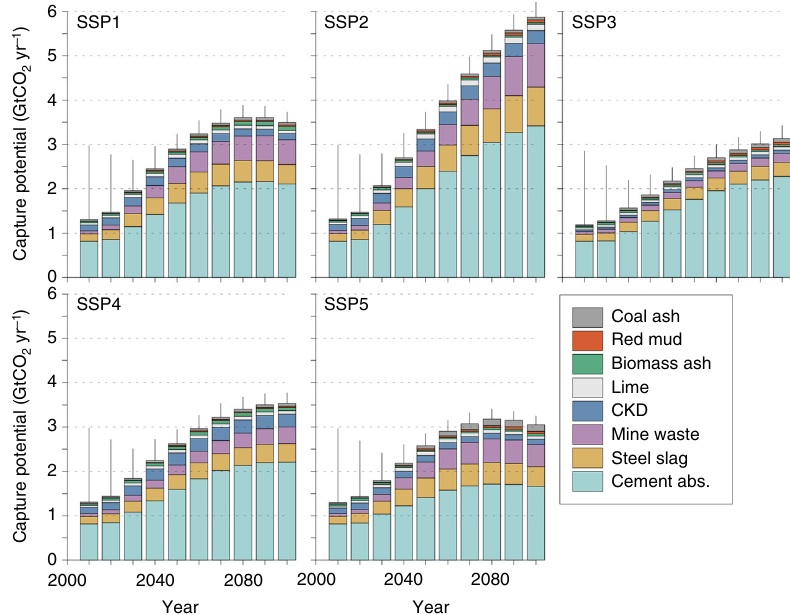
Fig. 3 Forecast of CO 2 capture potential through carbonation of alkaline materials to 2100 for the baseline shared socio-economic pathways (SSPs). The error bars represent the standard error for the range of concentration pathways in the SSPs ( n = 4 for SSPs 1 and 3, and n = 5 for SSPs 2, 4 and 5) together with uncertainties of material production and consumption, and